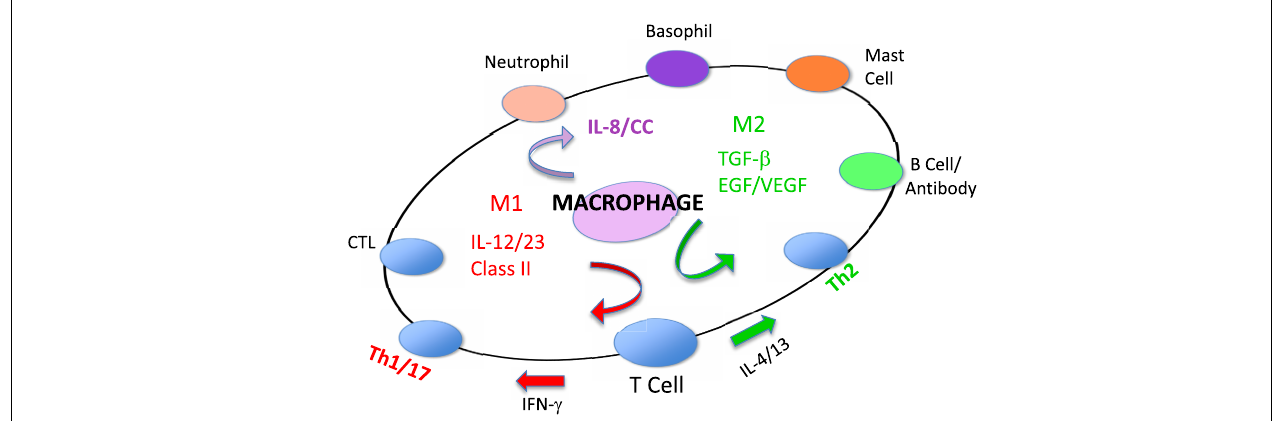
M1 activity. In contrast, M2-type macrophages cause T cells to produce molecules like IL-4 and TGF- β that cause B cells to produce antibody and elevate M2 responses. From Ref. (1) with permission from S. Karger AG, Basel.